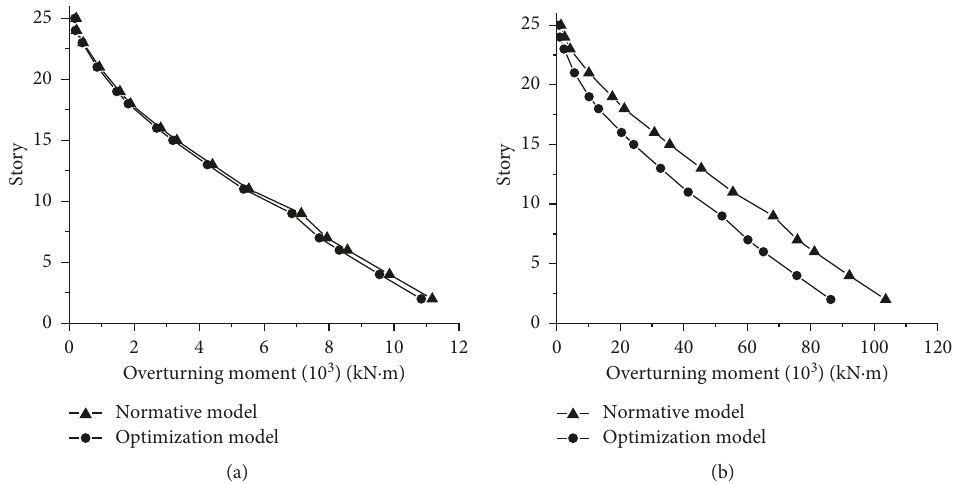
Figure 20: Comparison of maximum overturning moment. (a) Frequent intensity 7; (b) rare intensity